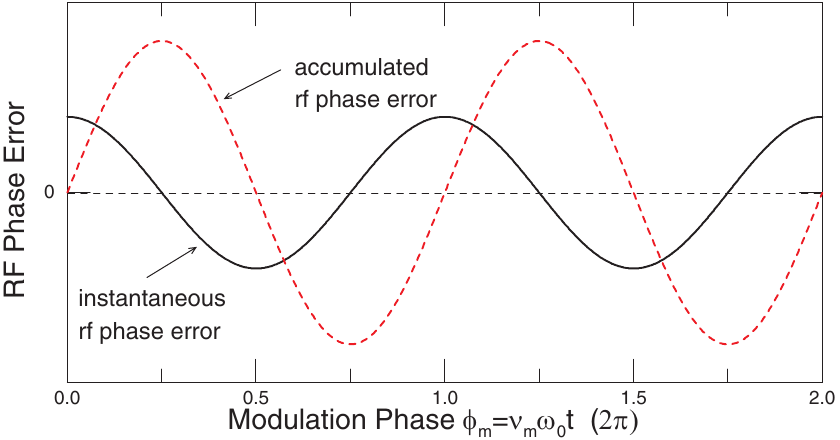
(cid:1) (cid:4) ! t m m 0